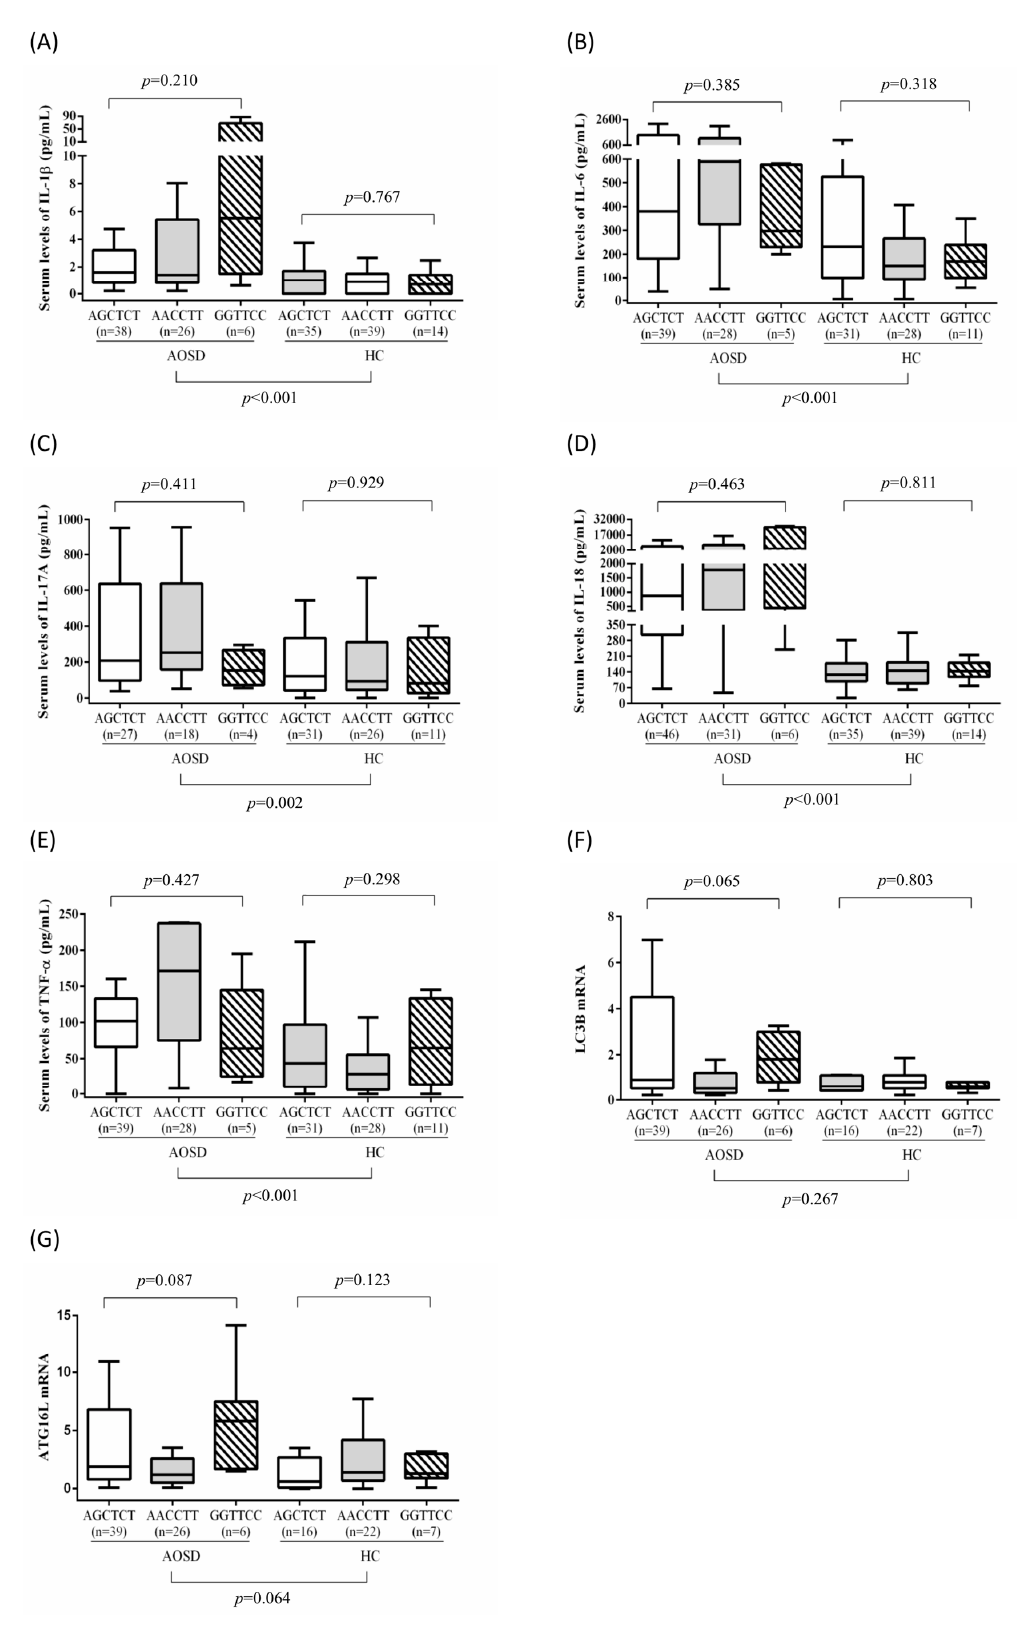
Figure 2. ( A – G ) Serum levels of IL-1 β , IL-6, IL-17A, IL-18, and TNF- α and mRNA levels of LC3-II and ATGL16L1 in patients with AOSD and healthy controls with different